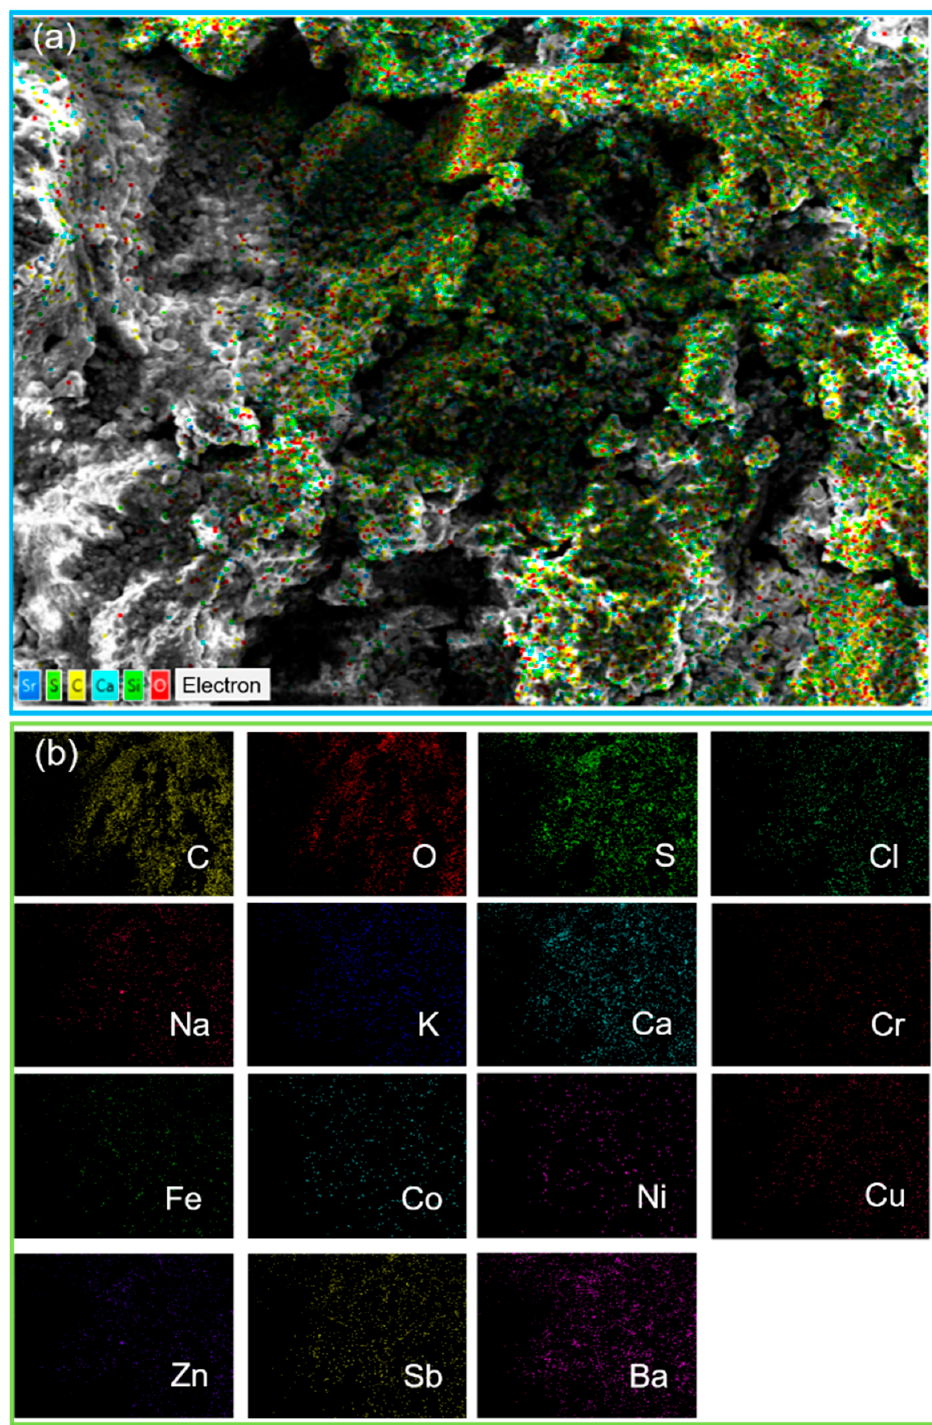
Figure 9. EDS profile ( a ) and elemental mappings ( b ) involved in the surface of shale gas OBDCs before treatment.